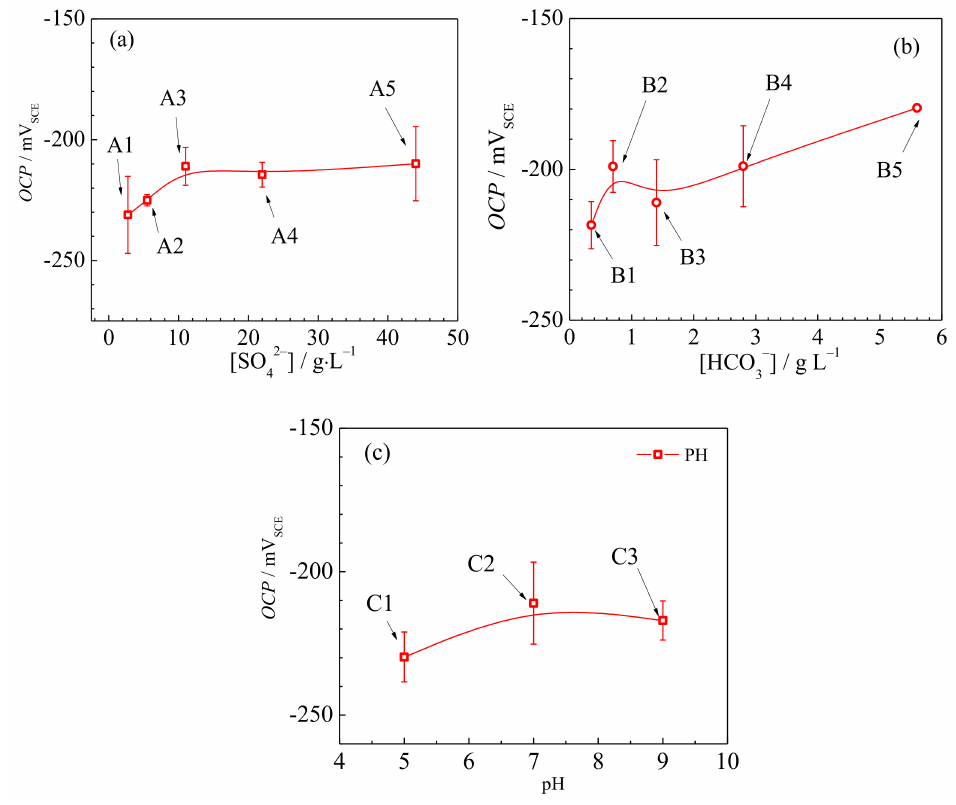
Figure 2. The OCP values of the 201 low-nickel stainless steel in the underground water with different contents of salinities and pH values, ( a ) A1–A5 solutions with different concentration of SO 42 − , ( b ) B1–B5 solutions with different concentration of HCO 3 − , and ( c ) C1–C3 solutions with different pH